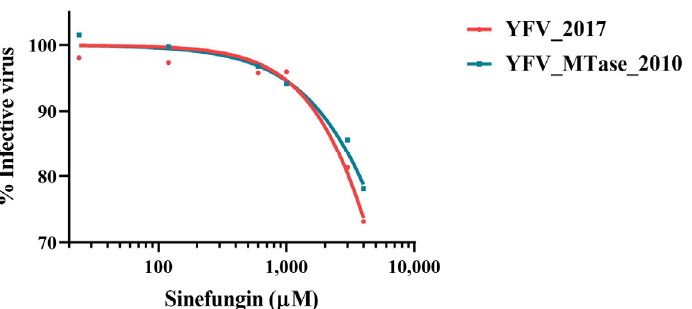
Figure 7. Viral replication in the presence of Sinefungin. The nonlinear fit of viral activity in the presence of the inhibitor molecule. Each point represents the result of four independent inhibition experiments. The nonlinear regression was conducted with the algorithm [Inhibitor] vs. normalized response—variable slope of GraphPad Prism 8.